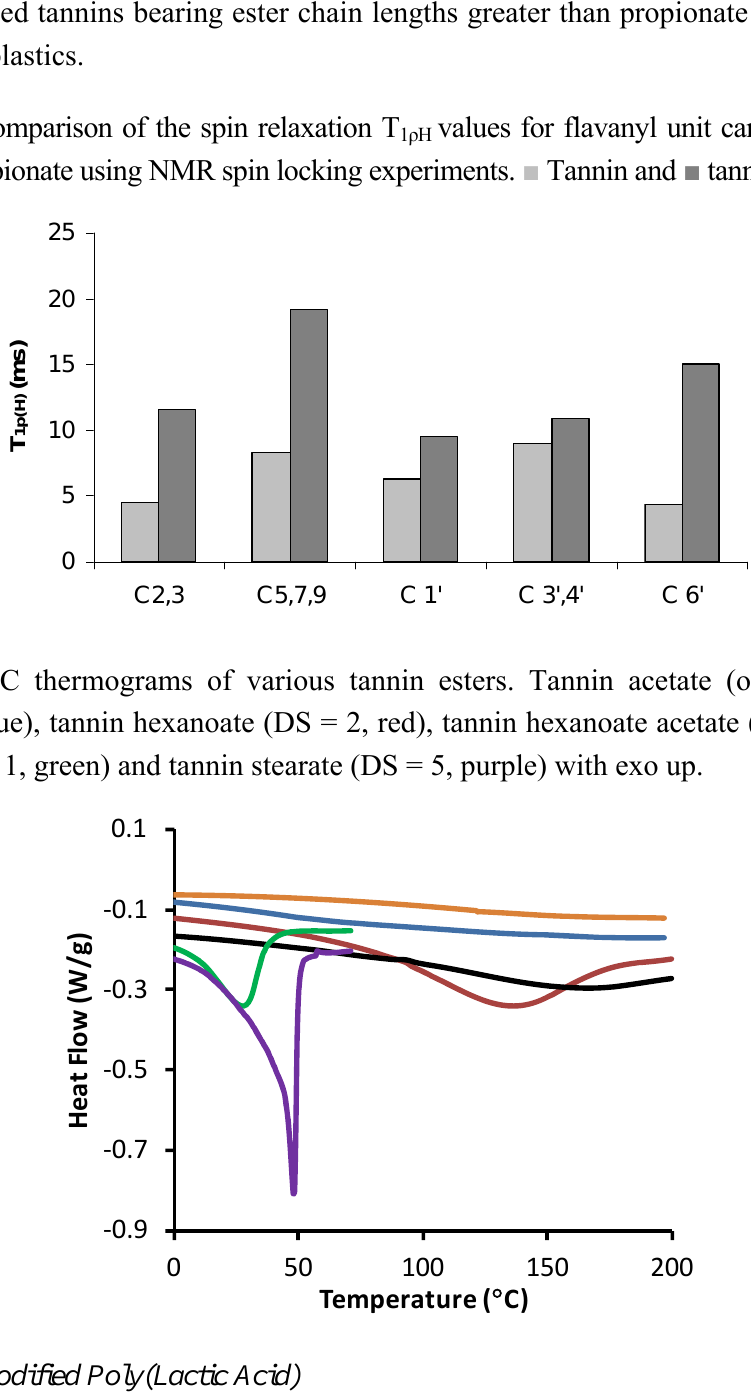
values for flavanyl unit carbons of tannin 1 ρ H